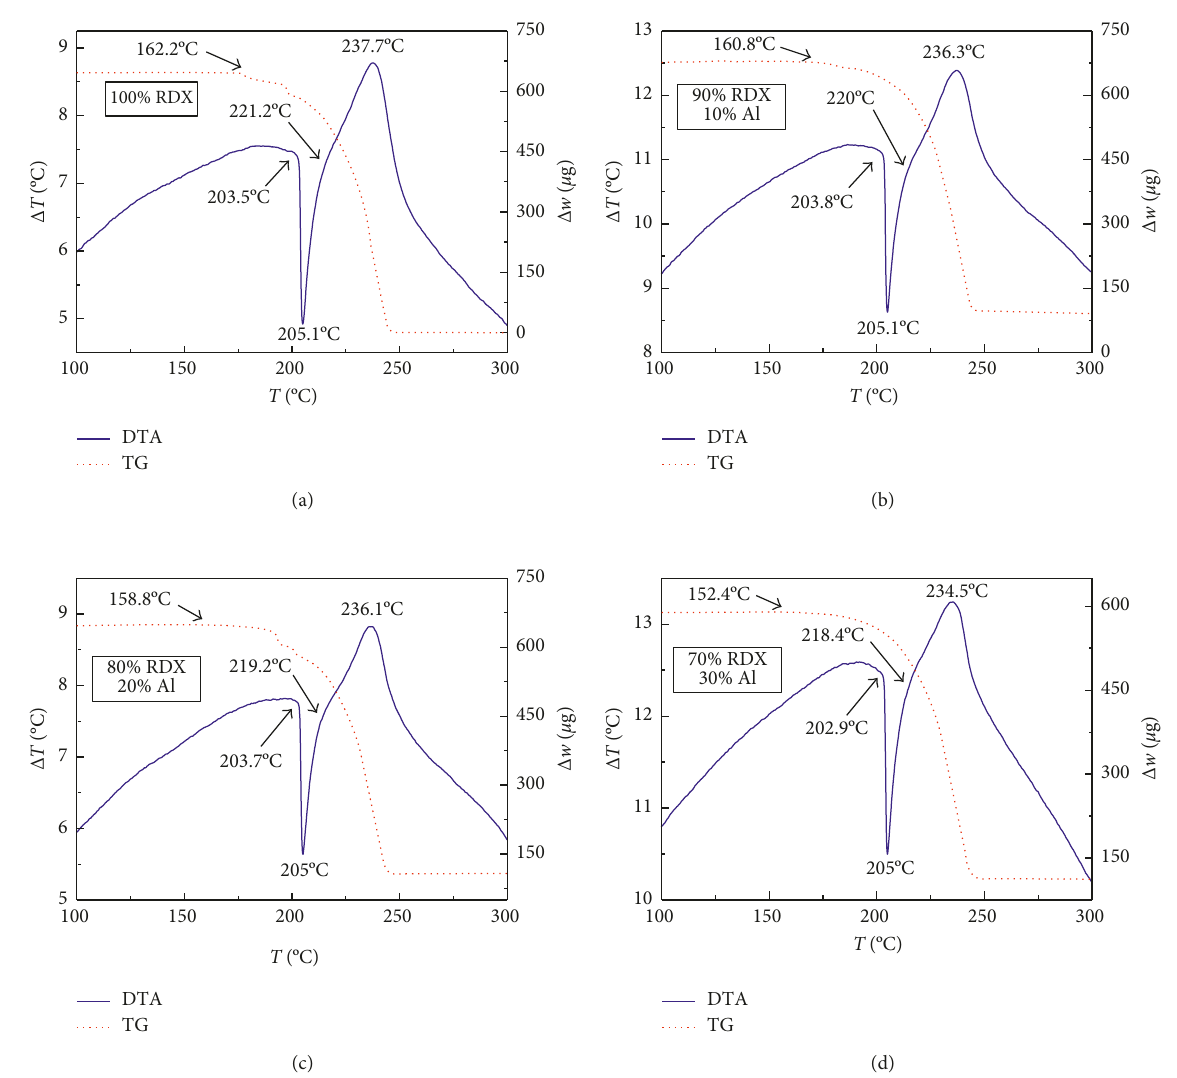
Figure 1: TG-DTA curves of RDX/Al. (a) Pure RDX; (b) RDX 90 wt.% and Al 10 wt.%; (c) RDX 80 wt.% and Al 20 wt.%; (d) RDX 70 wt.% and Al 30